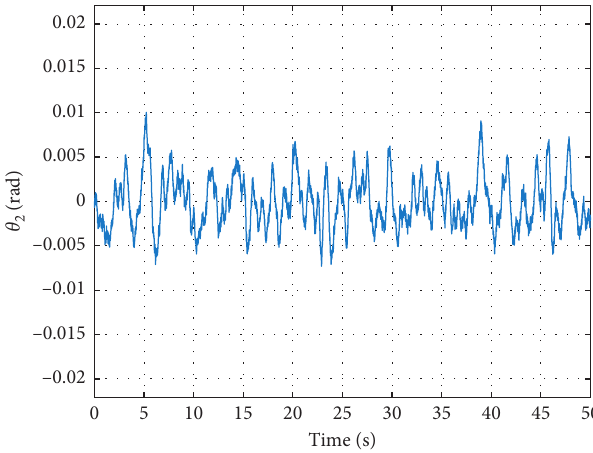
Figure 5: Car displacement.